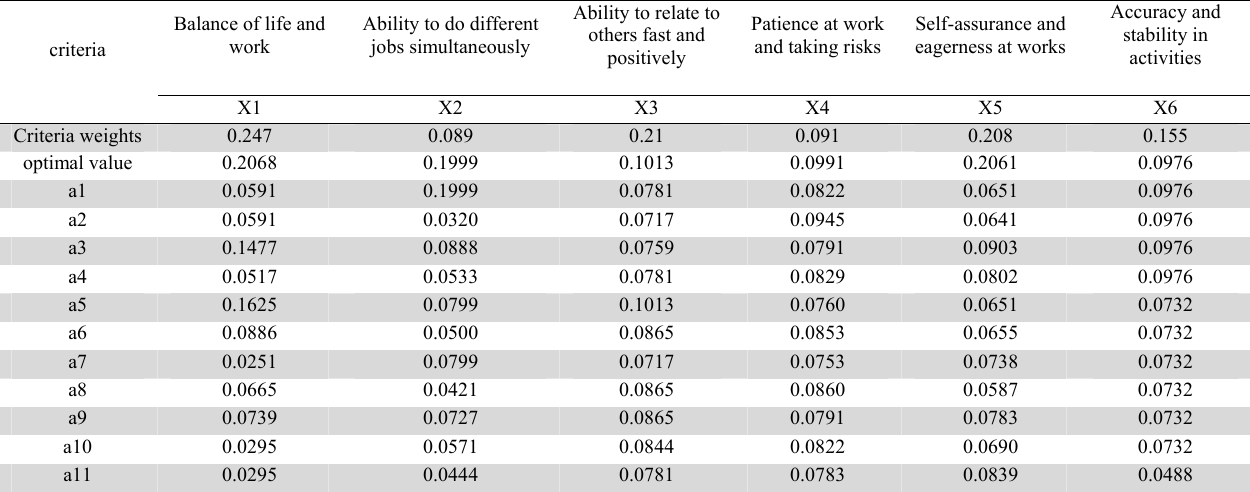
The results of normalization